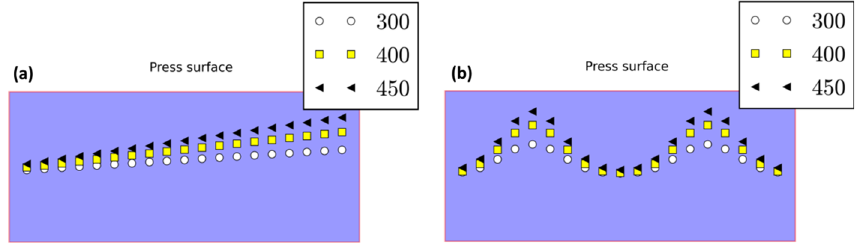
Fig. 11. Example of obtained positions of the heat for the tested pro fi les (a) pro fi le #1 and (b) pro fi le #2 corresponding to the runs #1, #3 and #5.